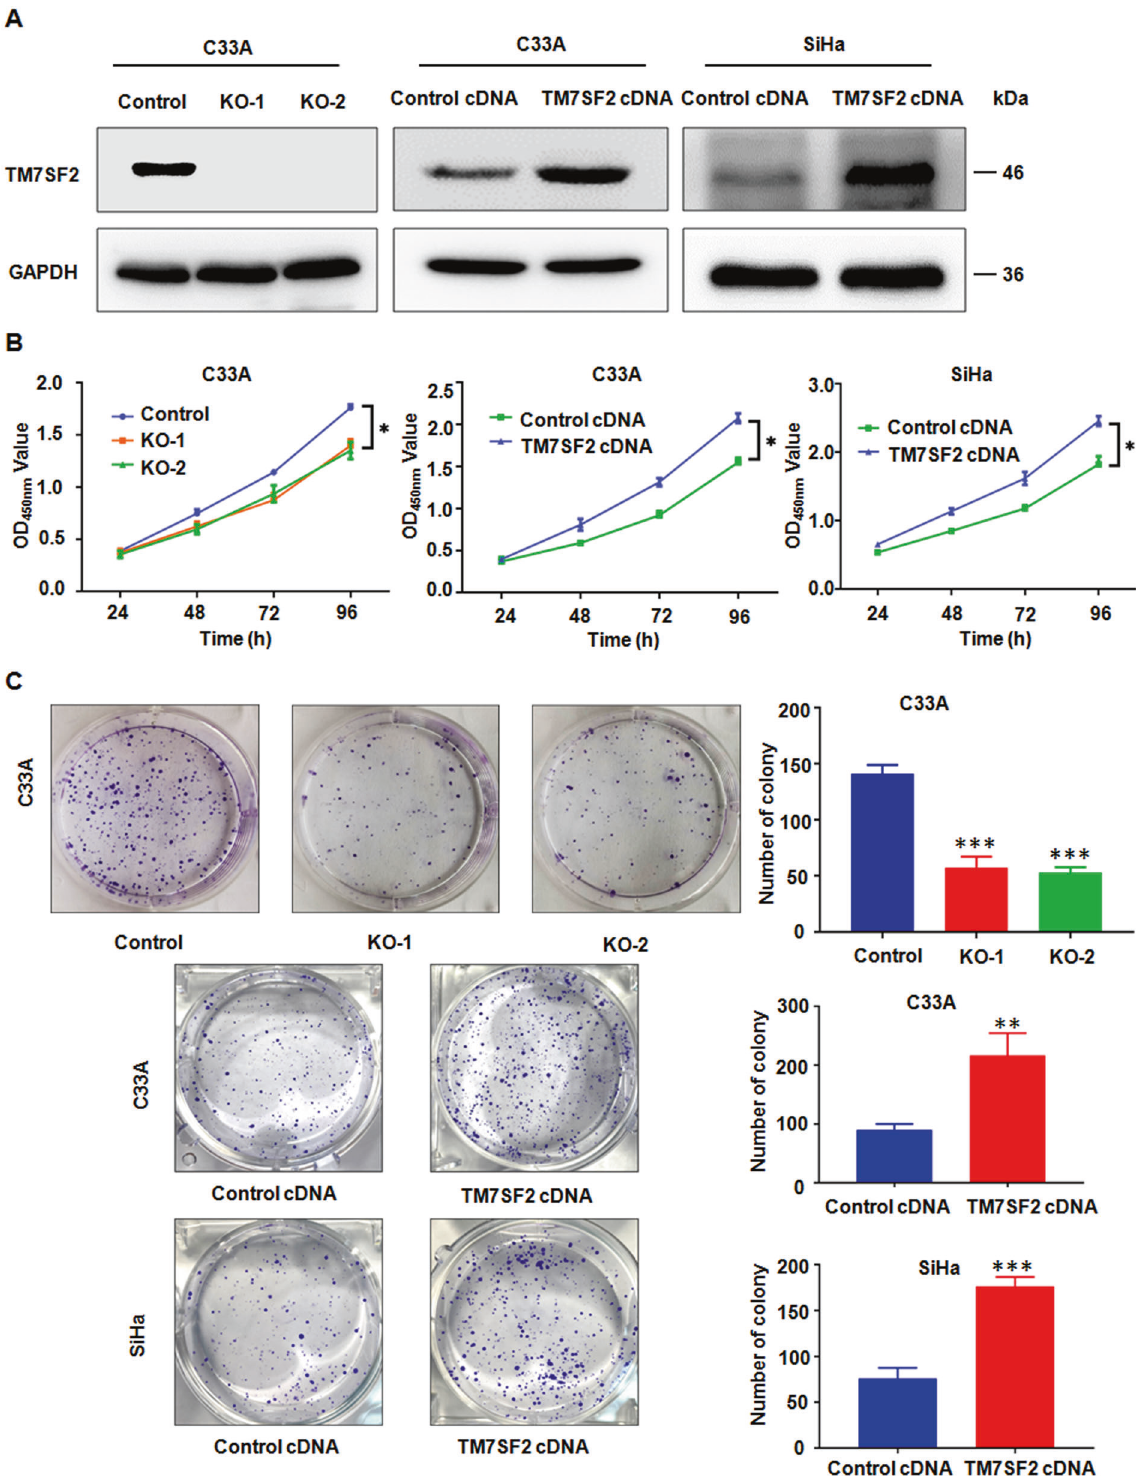
Fig. 2 TM7SF2 promotes cell proliferation and colony formation in cervical cancer cells. A The ef fi cacy of TM7SF2 knockout or overexpression in C33A and SiHa cells were measured by western blotting. B The effect of TM7SF2 knockout or overexpression on cell proliferation ability was measured by CCK-8 assays in cervical cancer cells. * p < 0.05 compared to control. C Left panel: the effect of TM7SF2 knockout or overexpression on colony formation in cervical cancer cells. Right panel: quantitative analysis for left panel. ** p < 0.01, *** p < 0.001 compared to control.